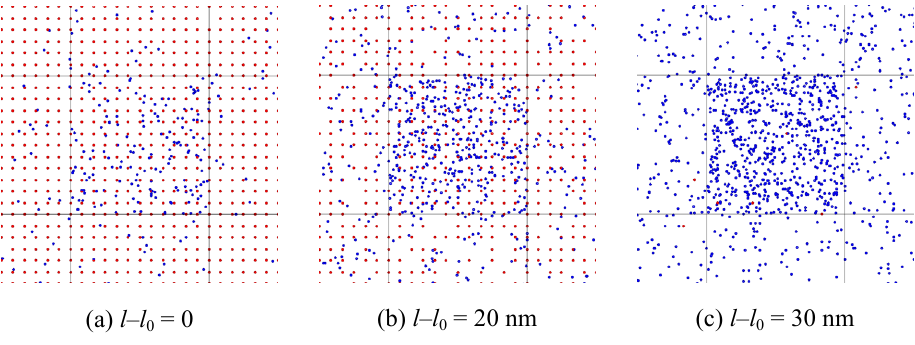
Snapshots of the center of the calculation area. The framed square is the GPIb α -localized region. Blue dots: unbound GPIb α ; red dots: bound GPIb α = 5, K = 1 × 10 5 ( γ dens eq